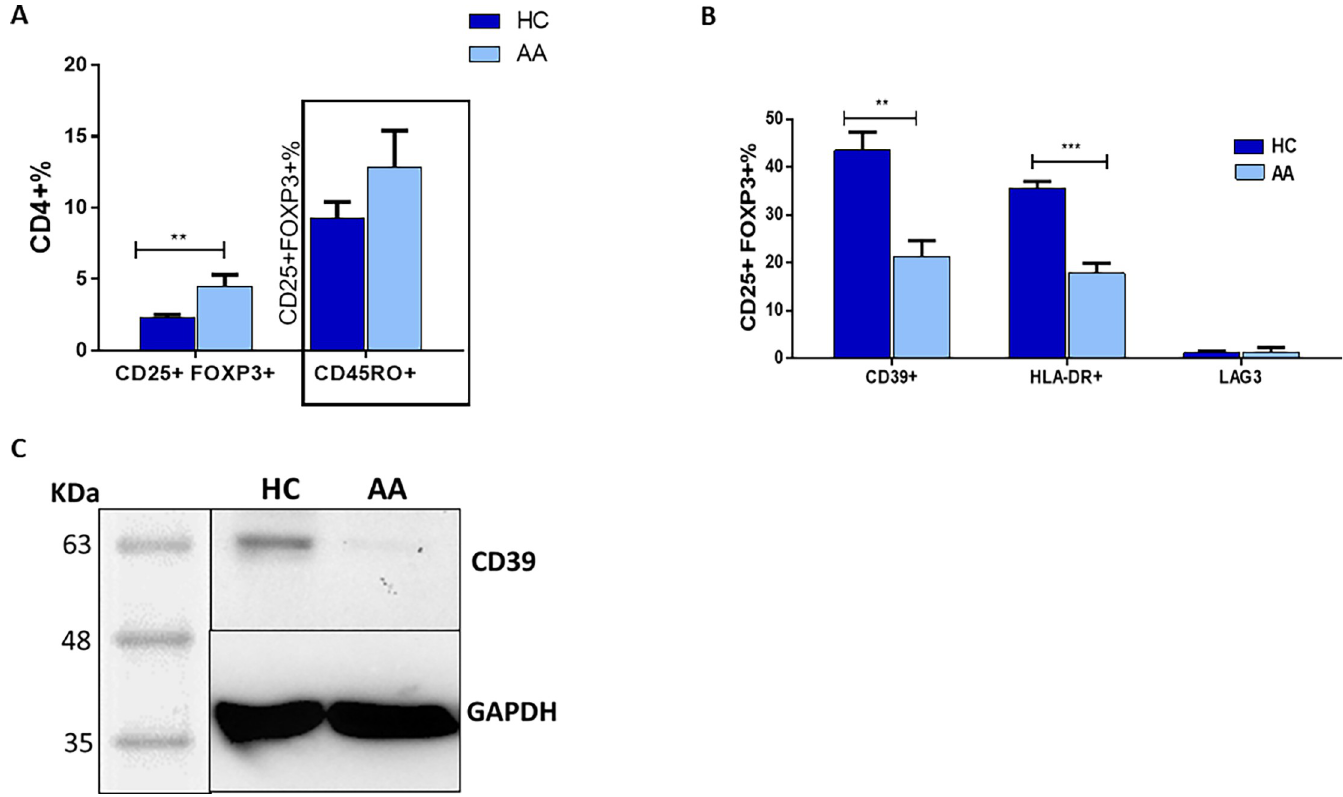
Fig 1. Flow cytometry identification strategies for Treg subsets (representative plots from one patient and one healthy control). A: Percentages of CD25+FOXP3 + Tregs and their memory subset (CD45RO+) in peripheral blood of AA patients and HC (see also supplementary data online). B : Suppressive subsets of CD25+FOXP3 + Treg cells. The percentage of suppressive subsets indicated by expression of CD39, HLA-DR or LAG3 surface makers was calculated out of the total Treg pool. Data analysed by a two-tailed independent t-test, and the corrected t-test was used whenever the homogeneity of variance was violated. A 95% confidence interval was used where P � 0.05 is considered significant ( � ) P � 0.01 ( �� ), P � 0.001 ( ��� ). Error bars depict SEM in each study group. AA patients n = 20, healthy controls (HC) n = 15. C : CD39 protein expression in AA and HC PBMCs. PBMCs isolated from blood of AA and HC donors were lysed and loaded in SDS gel, CD39 protein was detected using rabbit monoclonal antibodies. CD39 protein (60KDa) was detected in HC but not AA